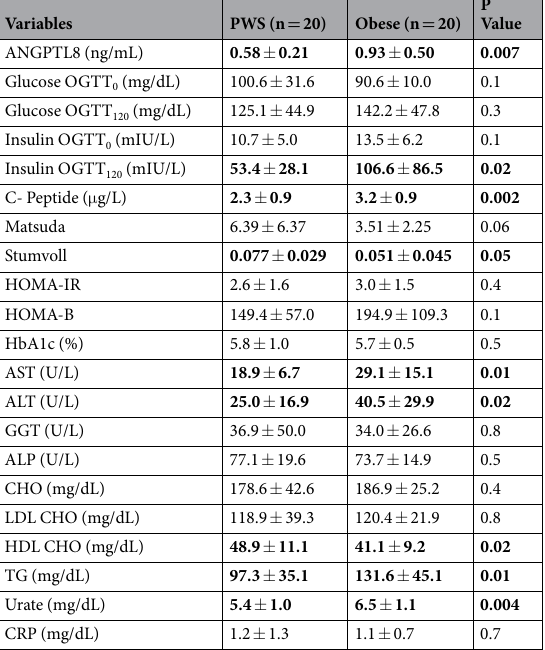
4 Scientific RepoRts | 7: 3186 | DOI:10.1038/s41598-017-03538-7